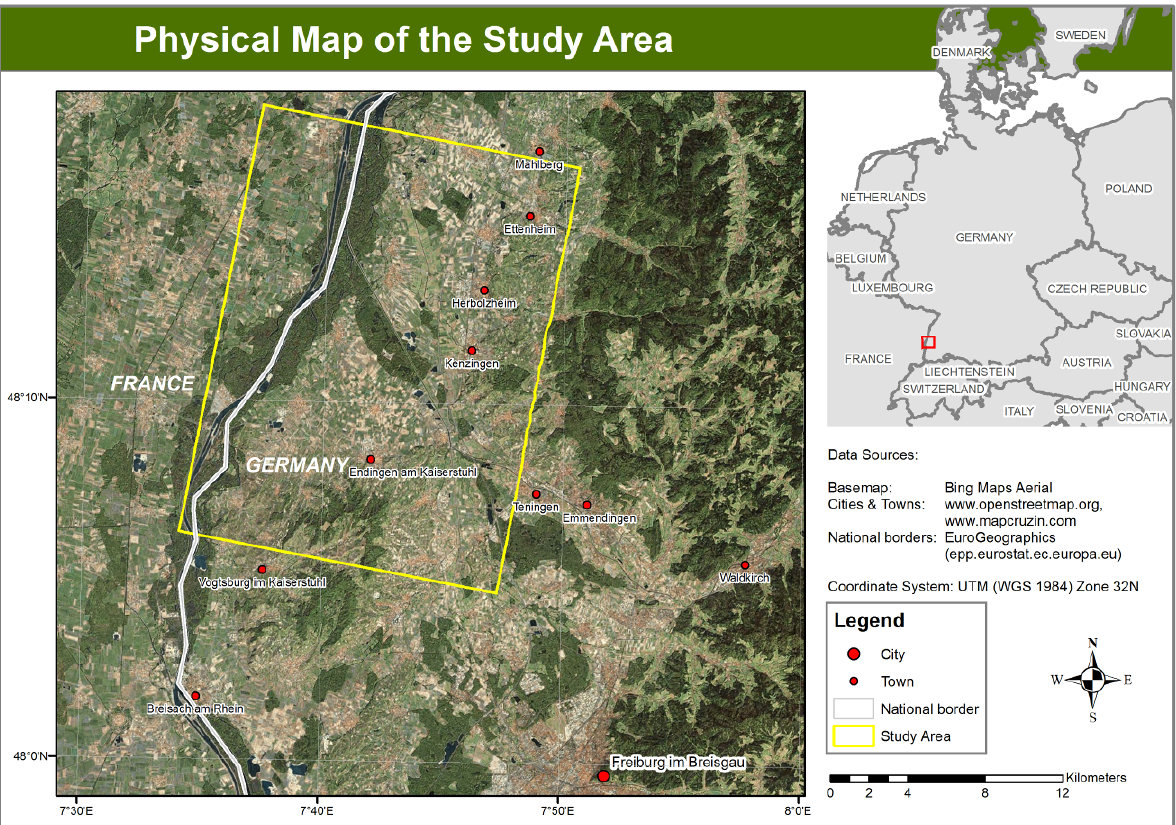
Figure 1: Physical Map of the Study Area “Taubergießen” in south-west